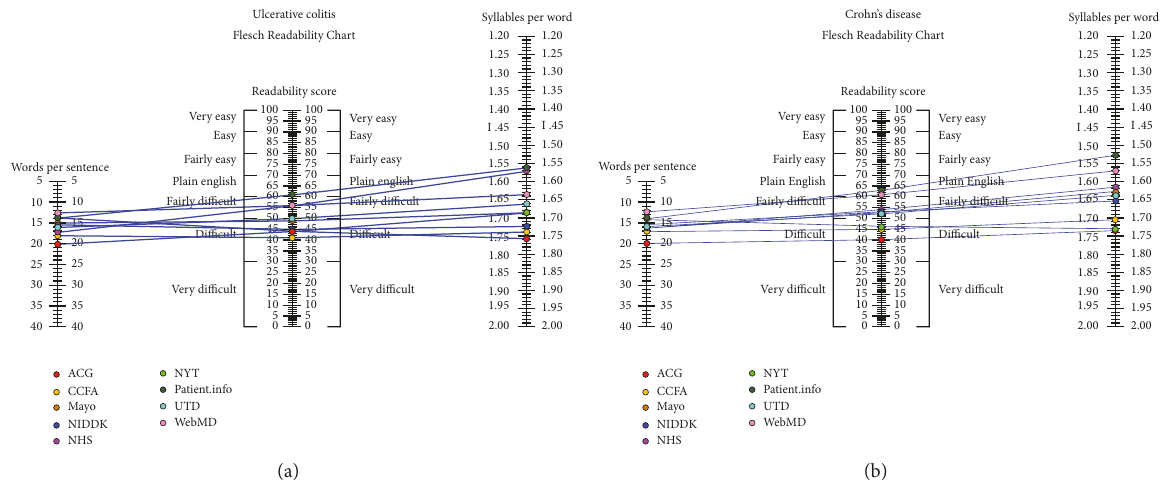
Figure 6: Flesch Readability Chart illustrating the components of the Flesch-Kincaid readability metric for each website of CD and UC, respectively. Each article was graded as a whole rather than the mean of the subsections under each article. Higher words per sentence and syllables per word result in a lower readability